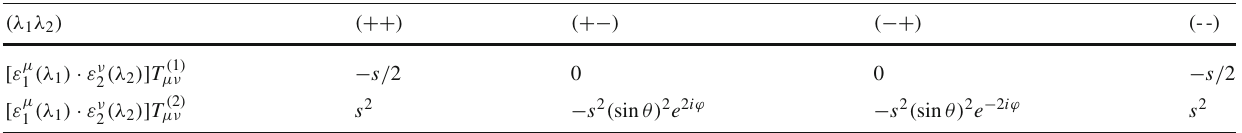
Table 1 Lorentz structures ε of Bose symmetry that guarantees M (γγ → ω + ω − ) LO , NLO = M (γγ → ω − ω + ) LO ,